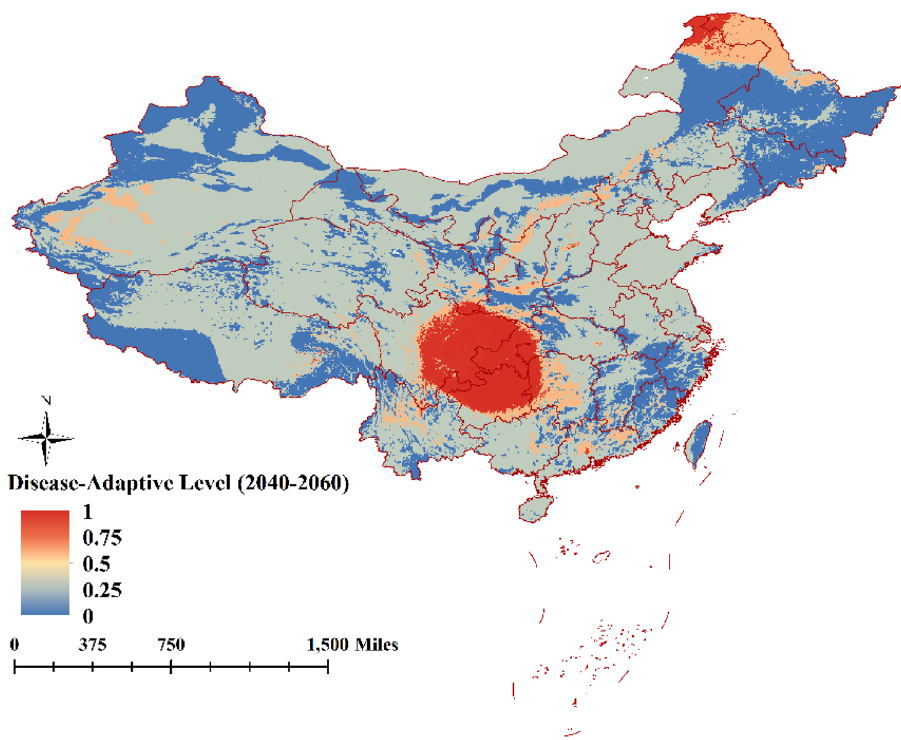
Figure 7. The model predicts areas suitable for ASF from 2040 to 2060 (The map is made by ArcGIS10.2 https:// www. esri. com/ and R 4.1.3 software https:// mirro rs. bfsu. edu. cn/